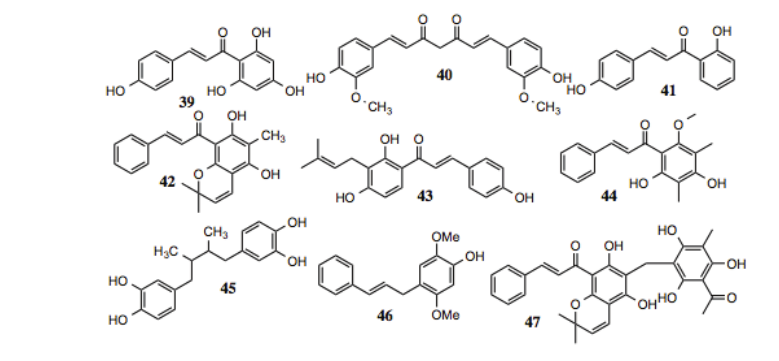
Figure 5. Chalones and related compounds.